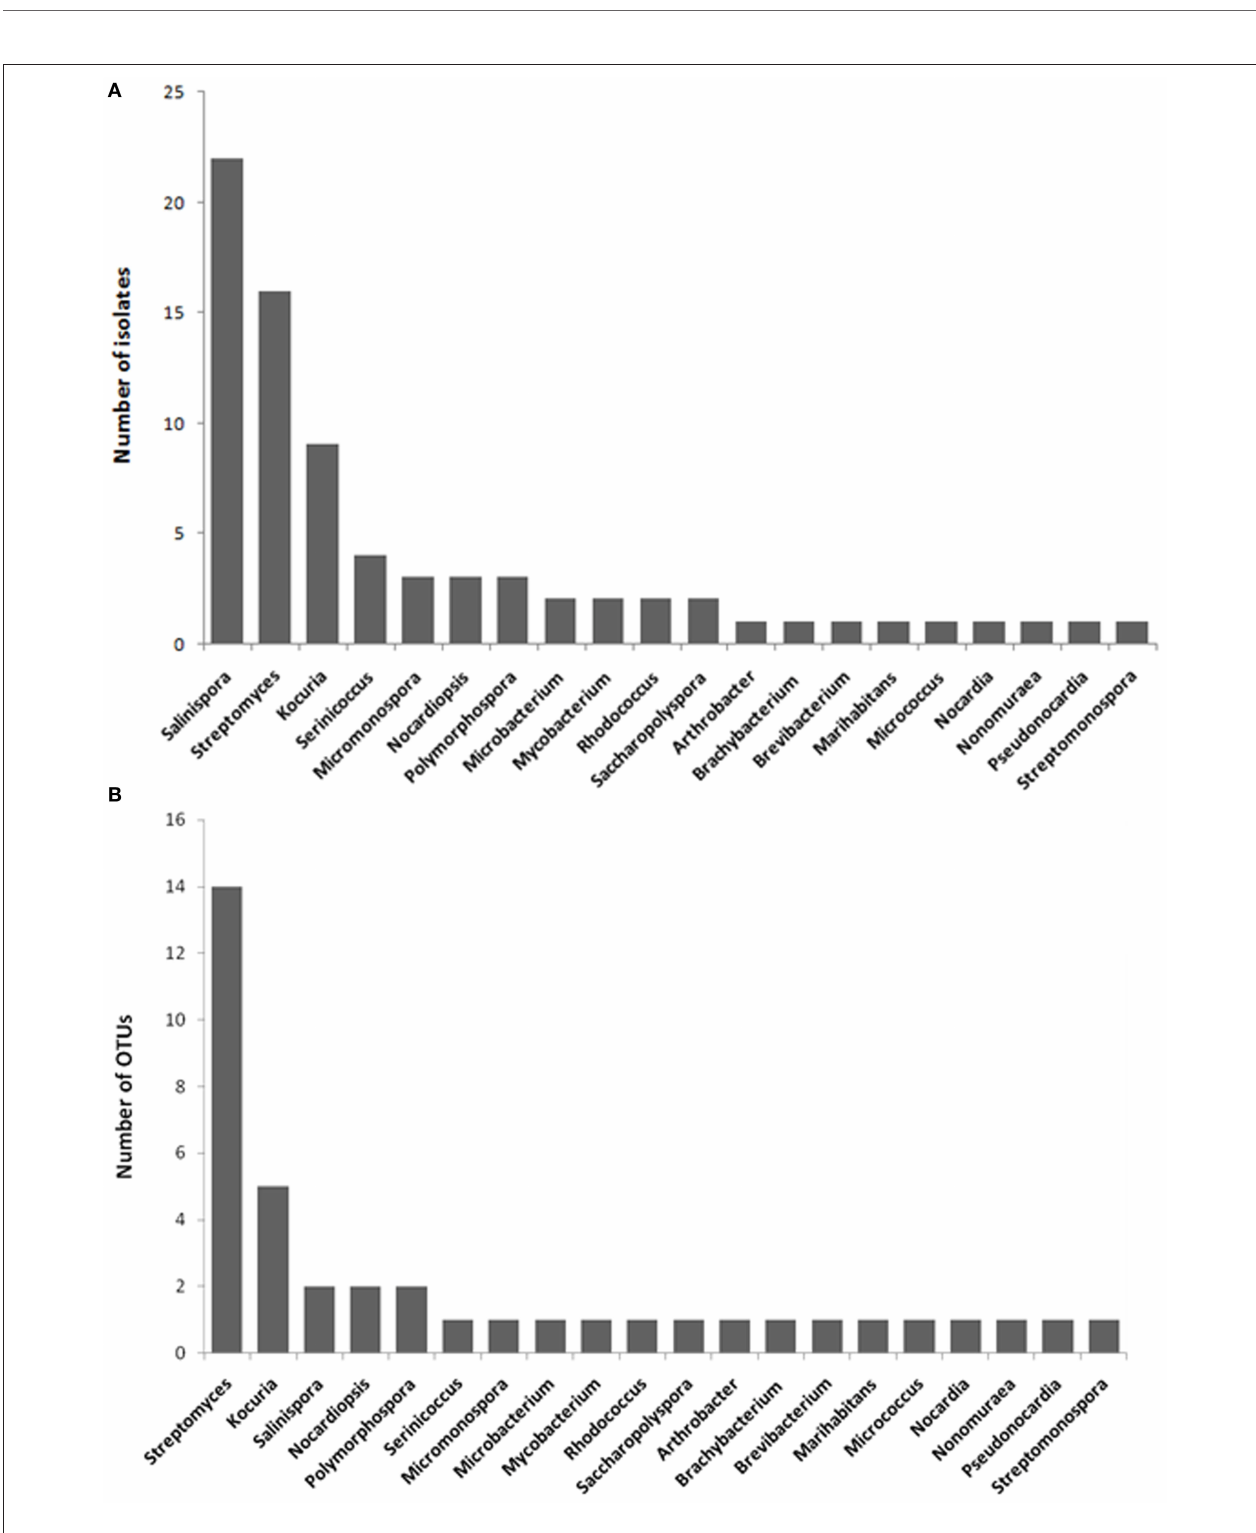
FIGURE 1 | Number of isolates (A) and OTUs per actinobacterial genus (B).